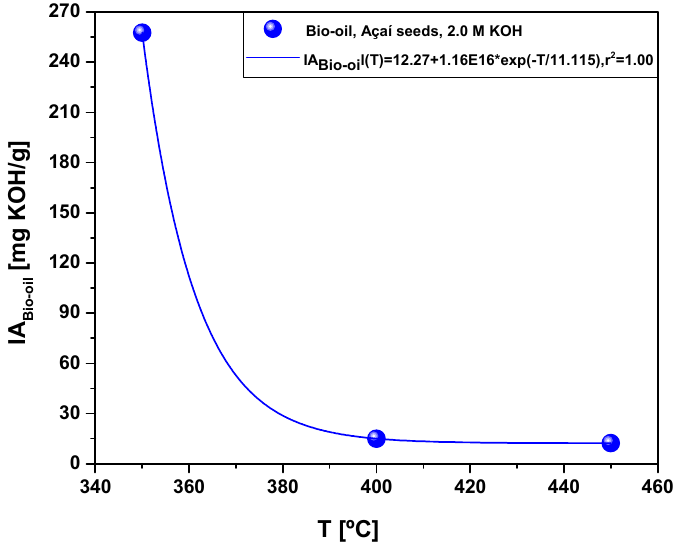
Figure 6. Acidity of bio-oil obtained by pyrolysis of Açaí seeds, activated with 2.0 M KOH solution, at 350, 400, and 450 °C, 1.0 atmosphere, in laboratory scale.